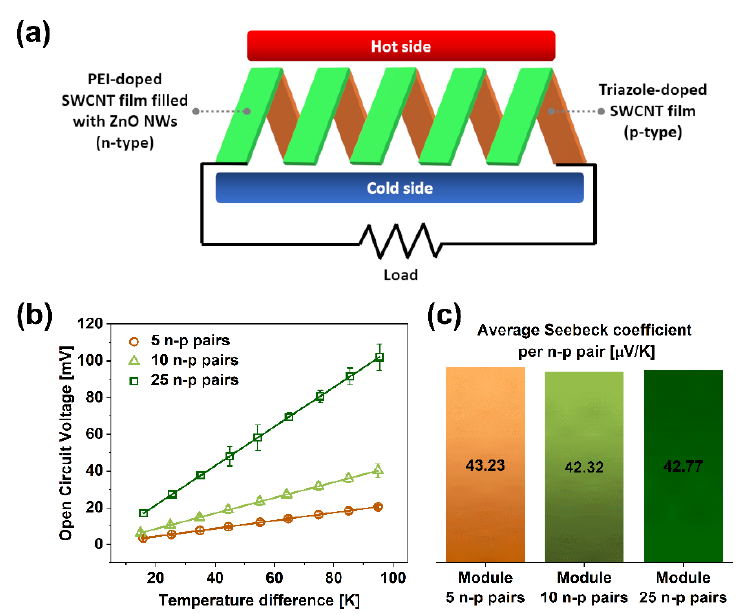
Figure 6. ( a ) Schematic representation of the evaluated module made from SWCNTs, ZnO NWs, and PEI/triazole as n- and p-dopants, respectively, ( b ) the magnitude of generated Open Circuit Voltage as a function of the temperature difference and the number of employed n–p pairs, and ( c ) average Seebeck coefficient per n–p pair determined from the slopes of the curves presented in panel ( b ).